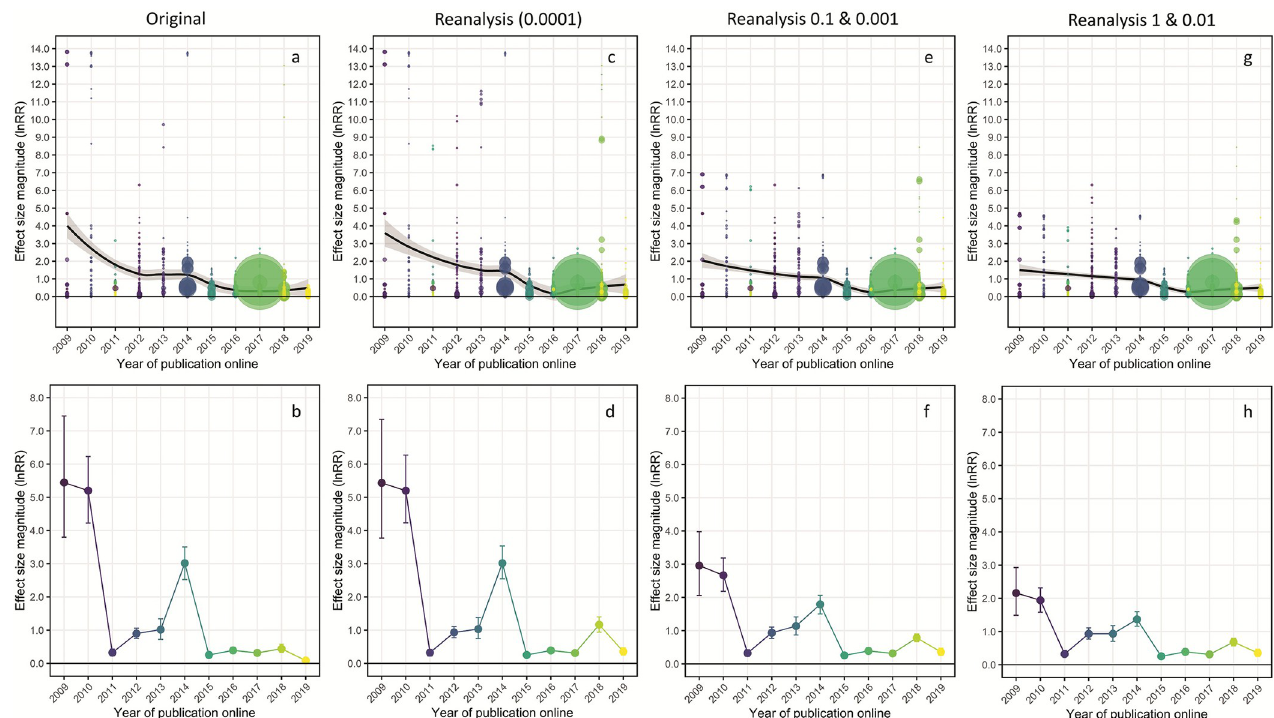
Fig 2. Comparison of decline effect and variance–weighted mean effect sizes with different methods of correcting for zero values in percentage and proportional data. (a, b) Original data from Clements and colleagues using 0.0001 and reanalysis with (c, d) corrected, updated, and screened data using 0.0001; (e, f) corrected, updated, and screened data using 0.1 for percentage data and 0.001 for proportional data; and (g, h) corrected, updated, and screened data using 1 for percentage data and 0.01 for proportional data. Data underlying this figure may be found at https://doi.org/10.25903/jw8m–9007.